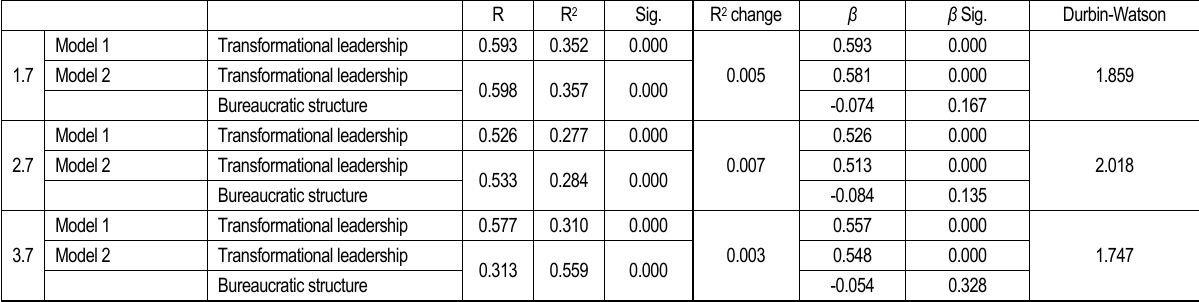
Table 8. Multiple regression analysis of transformational leadership on employee change readiness through perceived bureaucratic